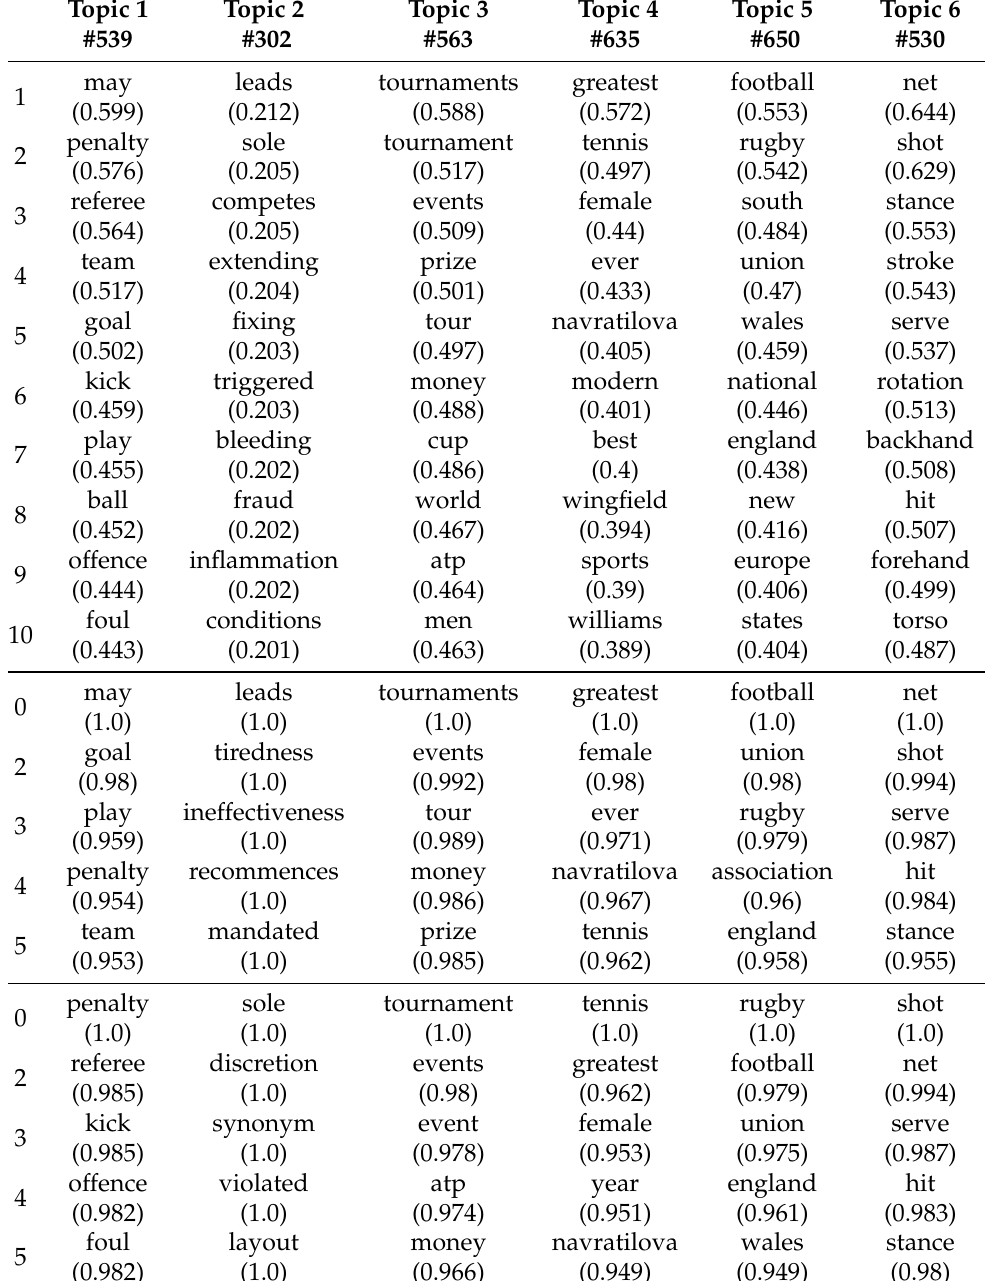
Table A4. Top half lists the top 10 representative words per dimension of the basis matrix A , bottom half lists the five most similar words based on cosine similarity for the two top words from each